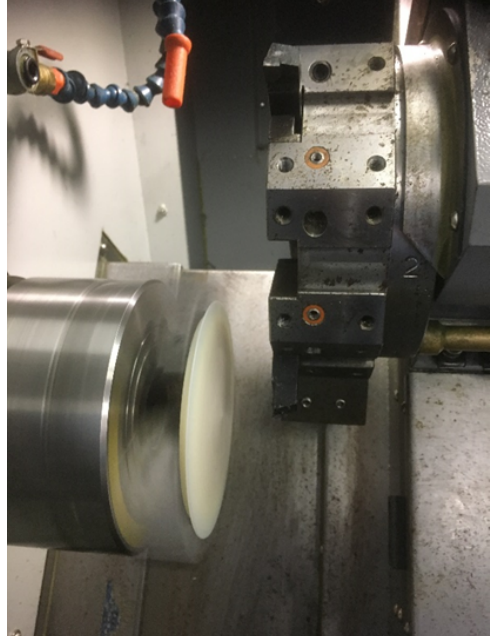
The roughness measurements performed in four quad- rants.